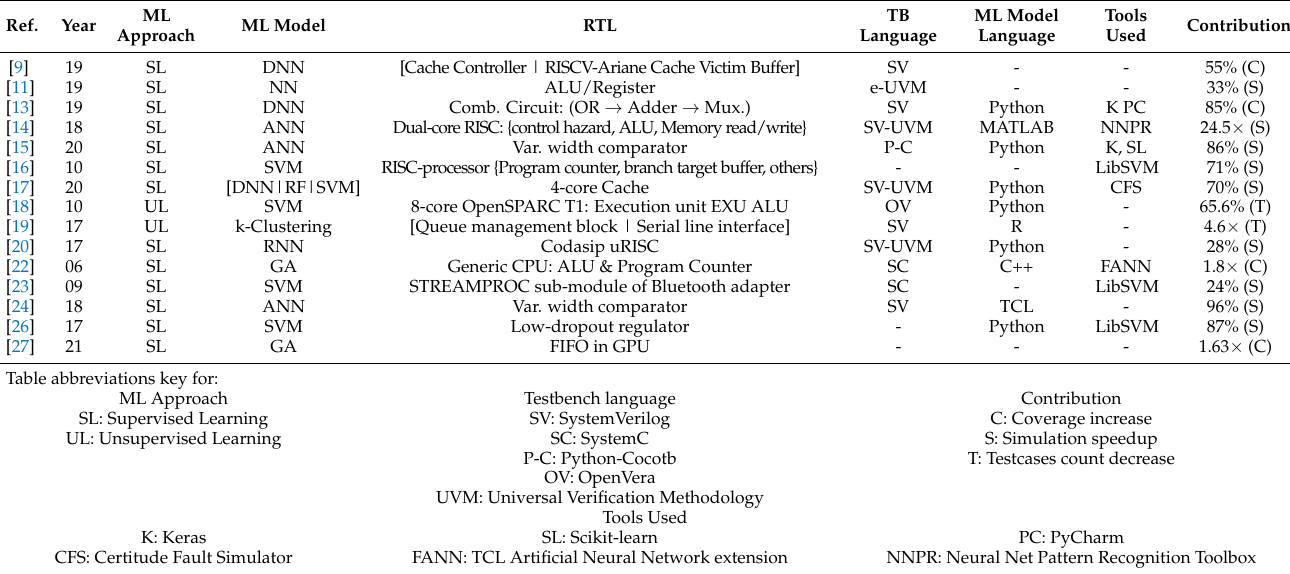
Table 1. Comparative summary of state of the art ML contributions in Section 5.1.